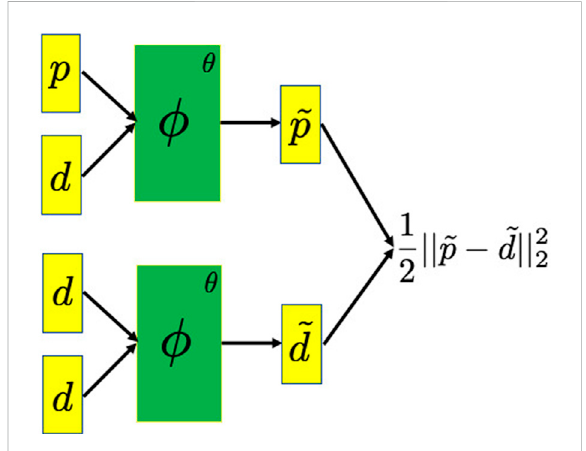
FIGURE 1 Schematic plot of the neural network architecture of the ML- mis fi t. The predicted data p and measured data d correspond to a single trace of the seismic data in vector form. They are packed to form two inputs, i.e., ( p , d )and ( d , d ). These inputs go through the neural network ϕ with parameters θ , and outputs ~ p and ~ d , respectively. The resulting mis fi t function is de fi ned to be the L2 norm of the difference between the outputs of ~ p and ~ d . See Section 2.1 for more